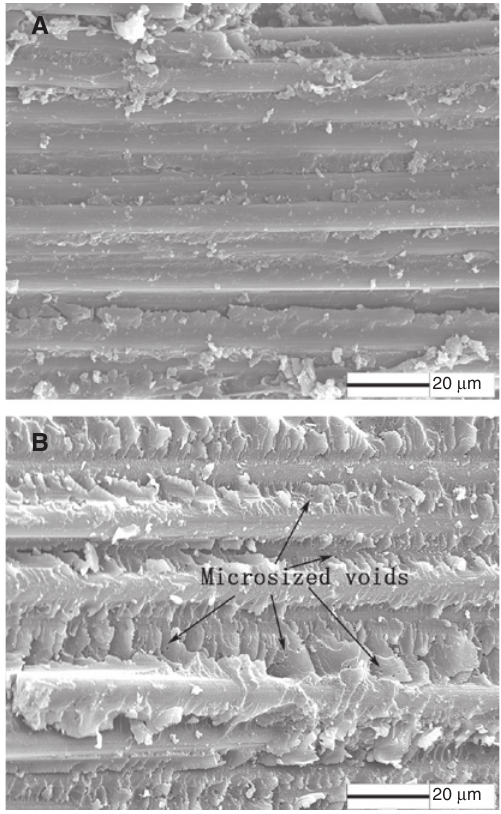
Figure 8: Microstructure of the 0 ° layer in carbon/benzoxazine composite specimen precured for different times at 80 ° C: (A) 0 min and (B) 30